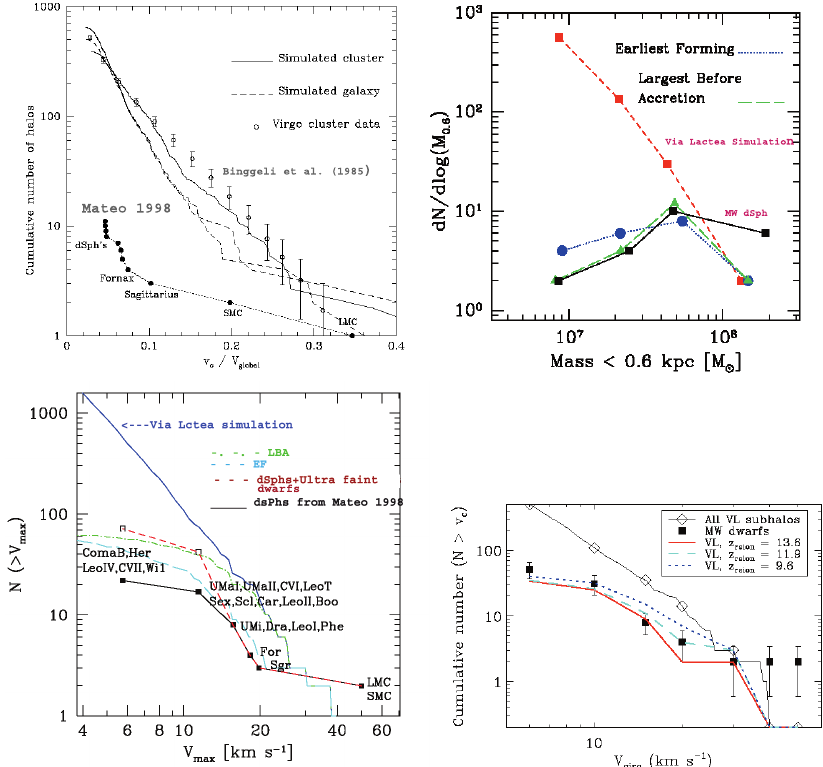
Figure 13. Top left panel: comparison, (from [32]) of the simulated cumulative clusters and dSphs number with observed clusters [387] and dSphs [388]. Top right panel: comparison of the abundances for the Via Lactea simulation (red dashed line) with the MW dSphs in the EF (blue dotted line), and LBA (green dashed line) scenarios (from [389]). Bottom left panel: comparison of the abundances for the Via Lactea simulation (blue solid line) with the MW dSphs (black line) , MW dSphs+Ultra-faint dwarfs (brown dashed line), and the EF (blue dashed line) , and LBA (dot-dashed green line) scenarii (from [390]). Bottom right panel: comparison of the abundances for the Via Lactea Simulation (black solid line) with the MW dSphs+Ultra-faint dwarfs (black dots), and with the Via Lactea subhaloes at redshifts 9.6 (dashed dark blue line), 11.9 (dashed light blue line), and 13.6 (solid red line), respectively (from